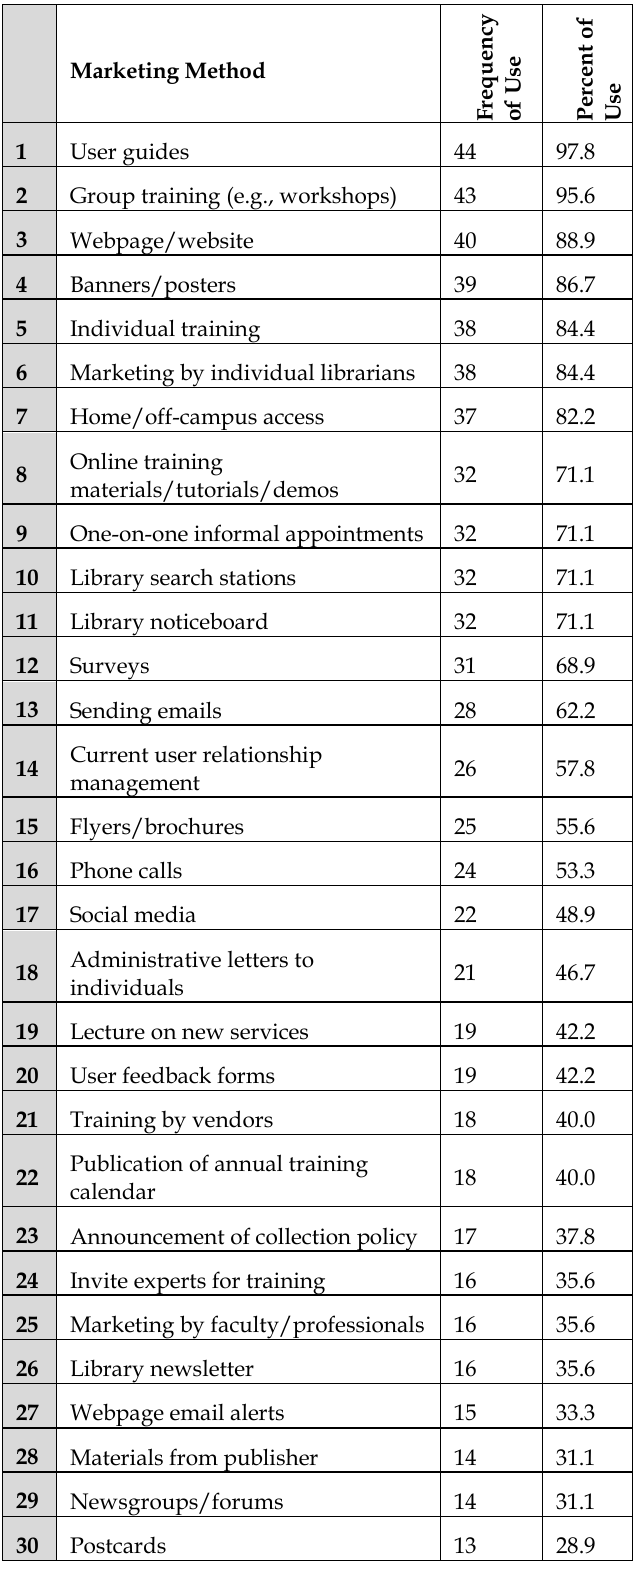
Table 1 Frequency of use of electronic resource marketing